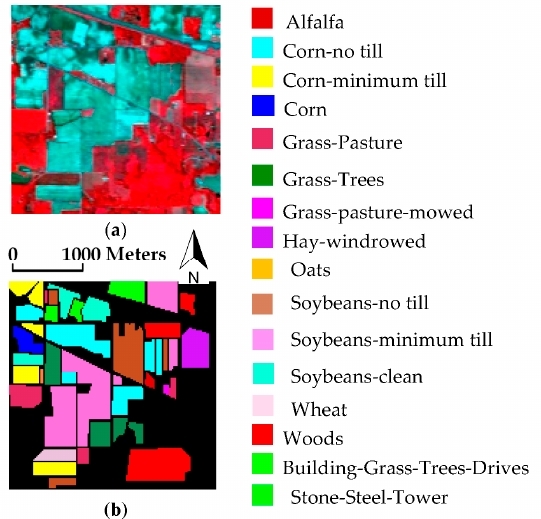
Figure 2. ( a ) False color composite of image of Bands 57 (927.61 nm), 27 (656.67 nm) and 17 (557.49 nm); and ( b ) available ground truth map (Indian Pines dataset).